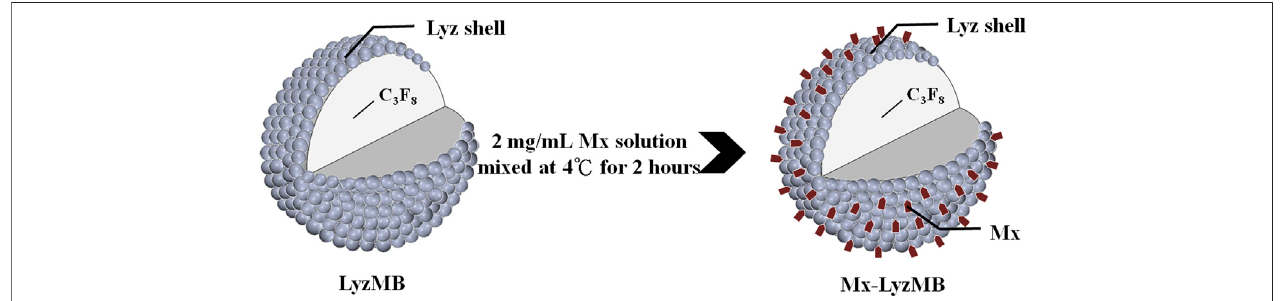
FIGURE 1 | Schematics (not to scale) of a LyzMB and an Mx-coated LyzMB (Mx in red color).